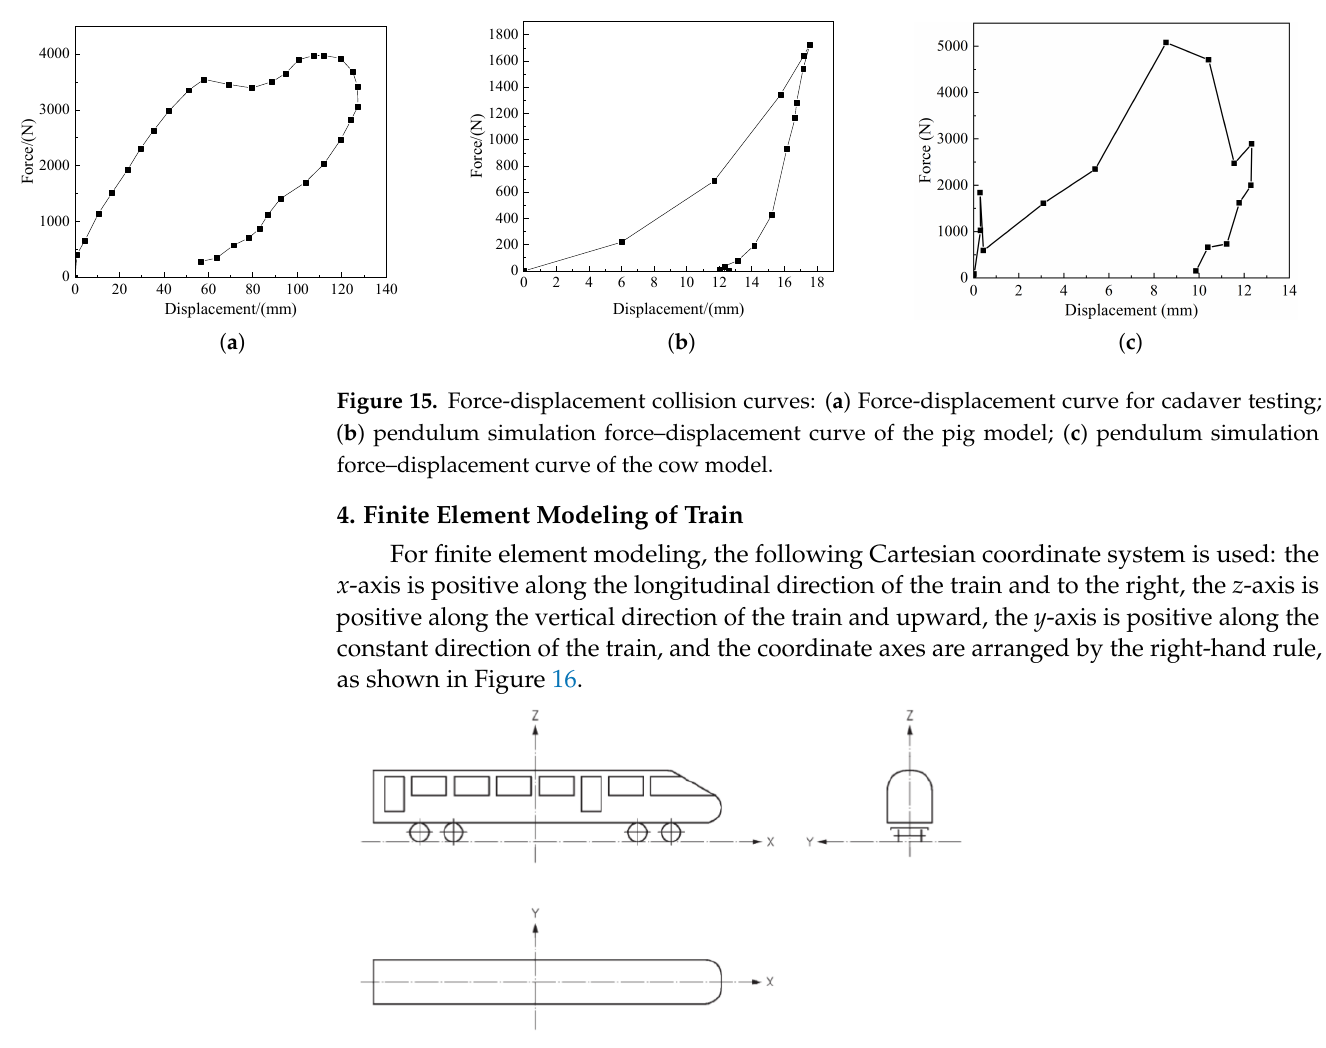
Figure 16. Train finite element model coordinate setting.